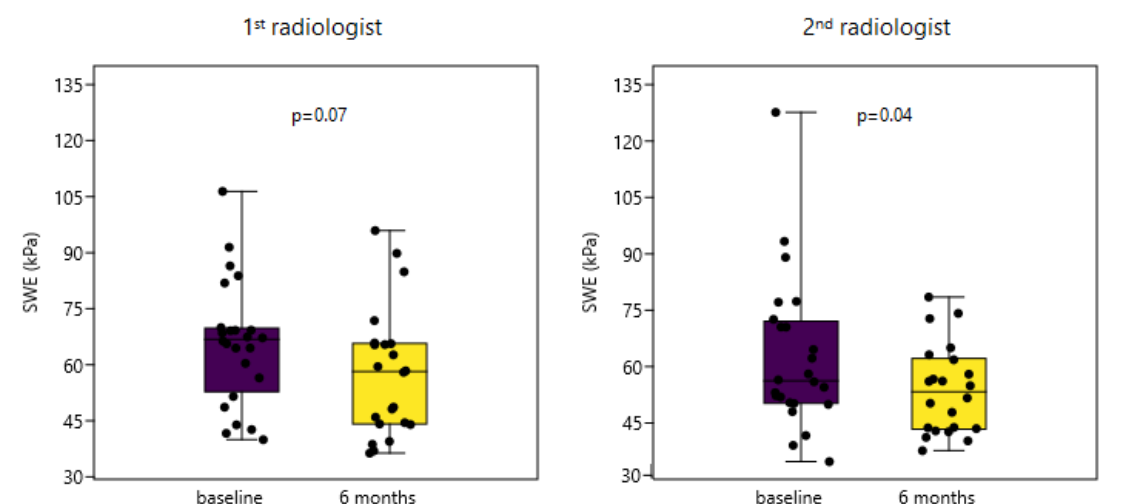
Figure 2. The difference of shear wave elastography (SWE) at baseline and 6-month follow-up measured by two radiologists. kPa, kilopascals. Table 2. Intra-observer reliability of elastography measurements in trapezius muscles before and after physical therapy.